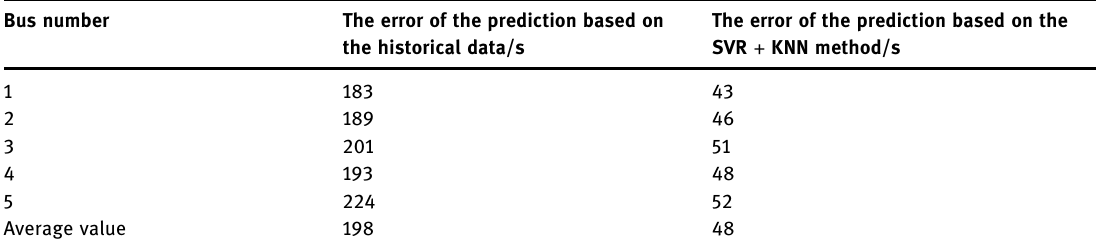
Table 5: The comparison of prediction errors of fi ve successive buses Bus